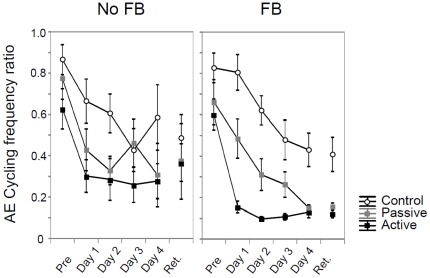
Performance of frequency ratio across days.Frequency ratio error changes across practice for each group in the absence (left) and presence of augmented feedback in the form of a Lissajous plot (right). Error bars represent SE of mean.